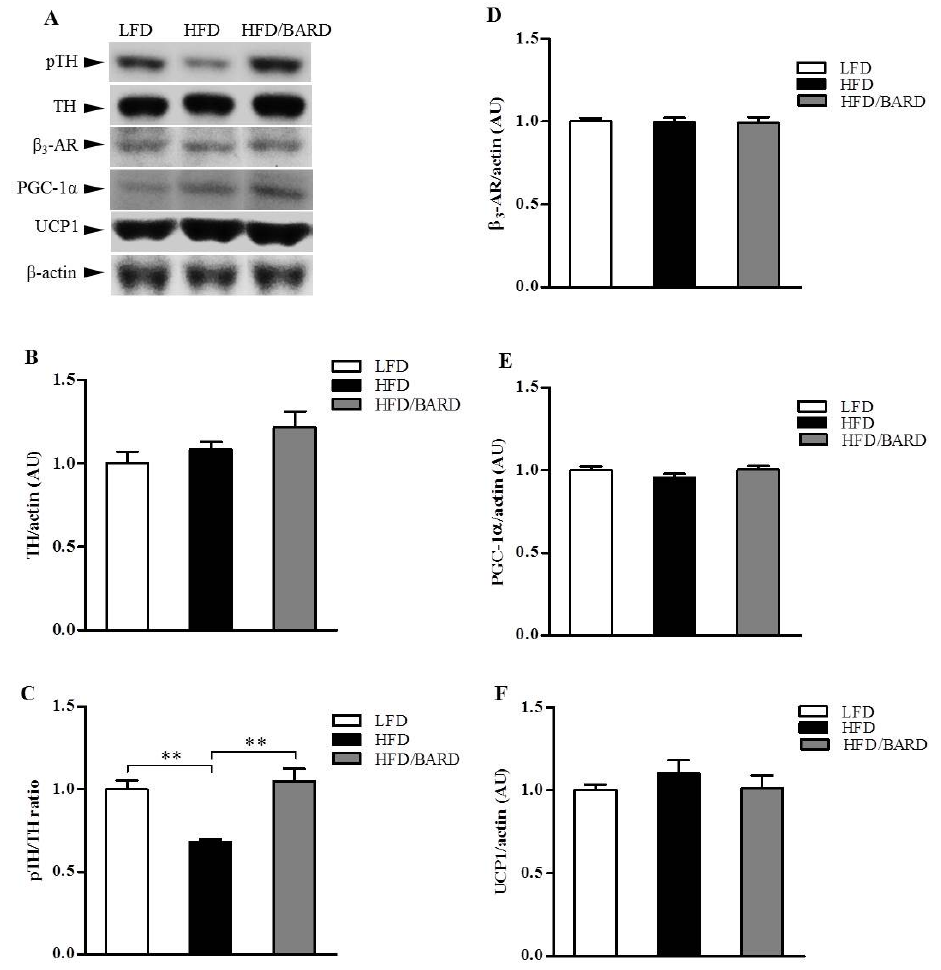
Figure 4. Effect of bardoxolone methyl (BARD) on noradrenergic innervation and energy expenditure proteins in brown adipose tissue of mice fed: low-fat diet (LFD), high-fat diet (HFD), and high-fat diet supplemented with BARD (HFD/BARD). ( A ) Representative blots; ( B ) Total TH protein; ( C ) pTH/TH ratio; ( D ) β 3 -AR protein; ( E ) PGC1- α protein; ( F ) UCP1 protein. All data are mean ± SEM. ** p < 0.01. TH: tyrosine hydroxylase; pTH: phosphorylated tyrosine hydroxylase; β 3 -AR: beta 3-adrenergic receptor; PGC1- α : peroxisome proliferator-activated receptor gamma coactivator 1-alpha; UCP1: uncoupling protein 1; AU: arbitrary